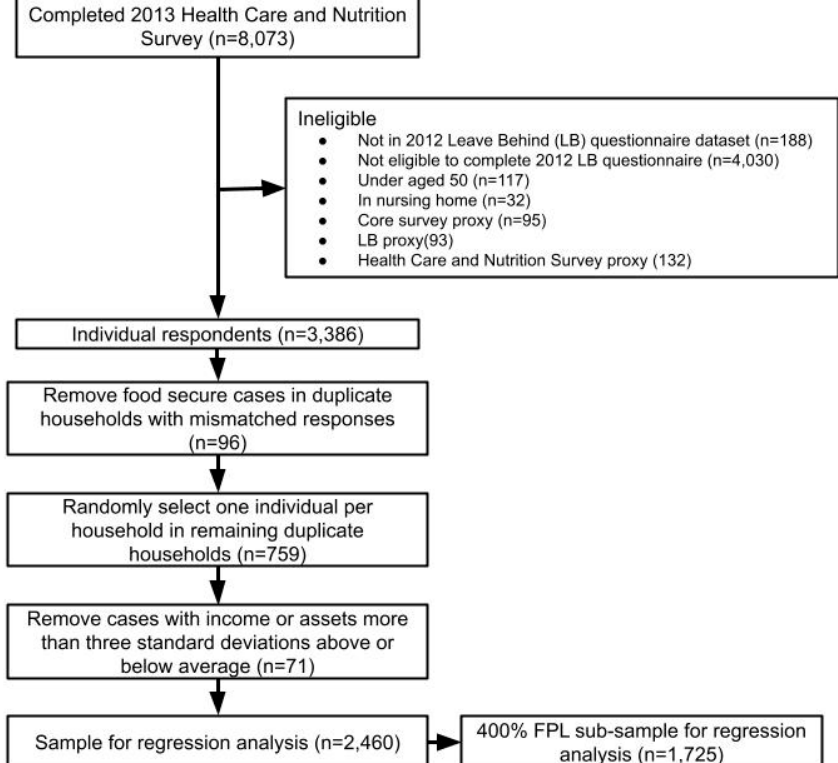
Figure 2. Flow chart showing procedure used to generate the study samples for analysis of the impact of political, economic, social, and cultural vulnerability on food insecurity using Health and Retirement Study data.